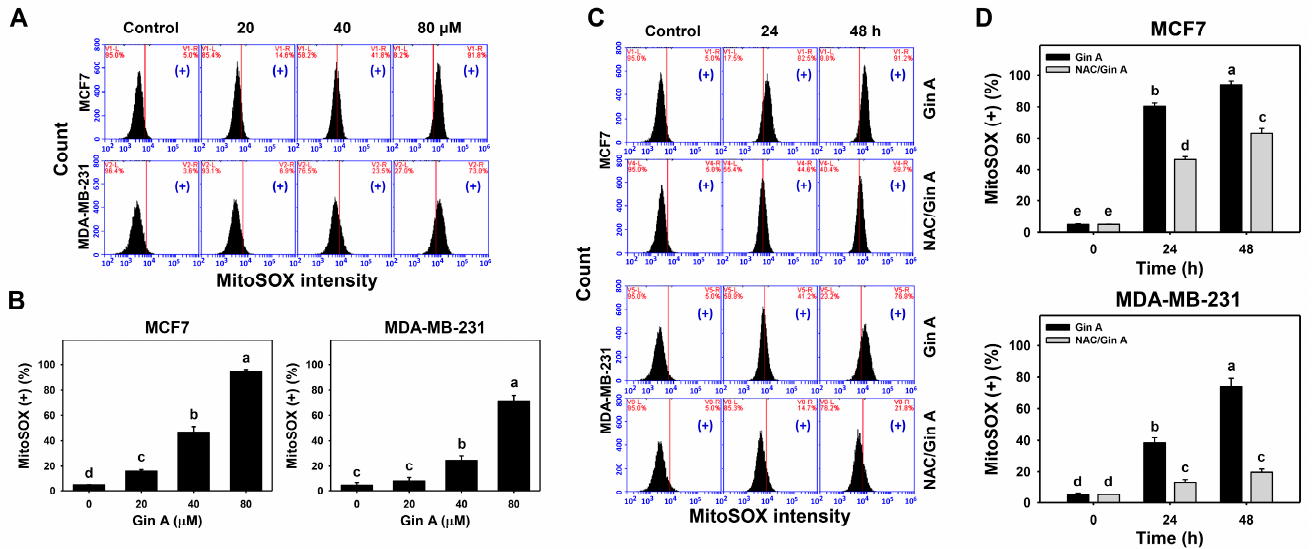
Figure 4. Impact of Gin A on MitoSOX level of breast cancer cells. ( A , B ) MitoSOX level. Cells were treated with 0 (0.1% DMSO; control), 20, 40, and 80 µ M Gin A for 48 h. Subsequently, they were subjected to MitoSOX flow cytometry. (+) indicates MitoSOX (+) populations. ( C , D ) NAC reverted effects on MitoSOX level. Cells were pretreated with NAC (10 mM) for 1 h and then post-treated with Gin A (control and 80 µ M) for 0, 24, and 48 h, namely NAC/Gin A. Data, means ± SDs ( n = 3). When the connecting letters are overlapping, it means that their difference is significant for multiple comparisons ( p < 0.05 to 0.0001). For the example of MCF7 cells ( D ), Gin A at 0, 24, and 48 h showing e , b , and a differs significantly. NAC/Gin A at 24 and 48 h showing d and c differs significantly, whereas Gin A and NAC/Gin A at 0 h showing the overlapped letter e differ